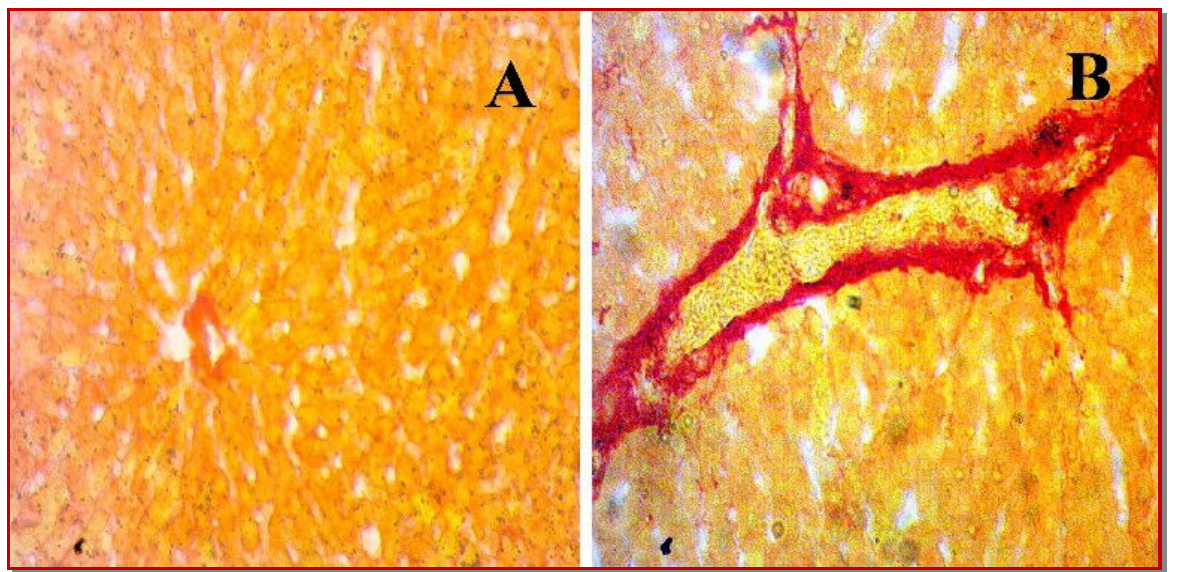
Figure 3: Toluidine blue staining showed mast cells infiltration (deep blue dots) in liver of rats treated with CCl 4 . A, Control; B, CCl